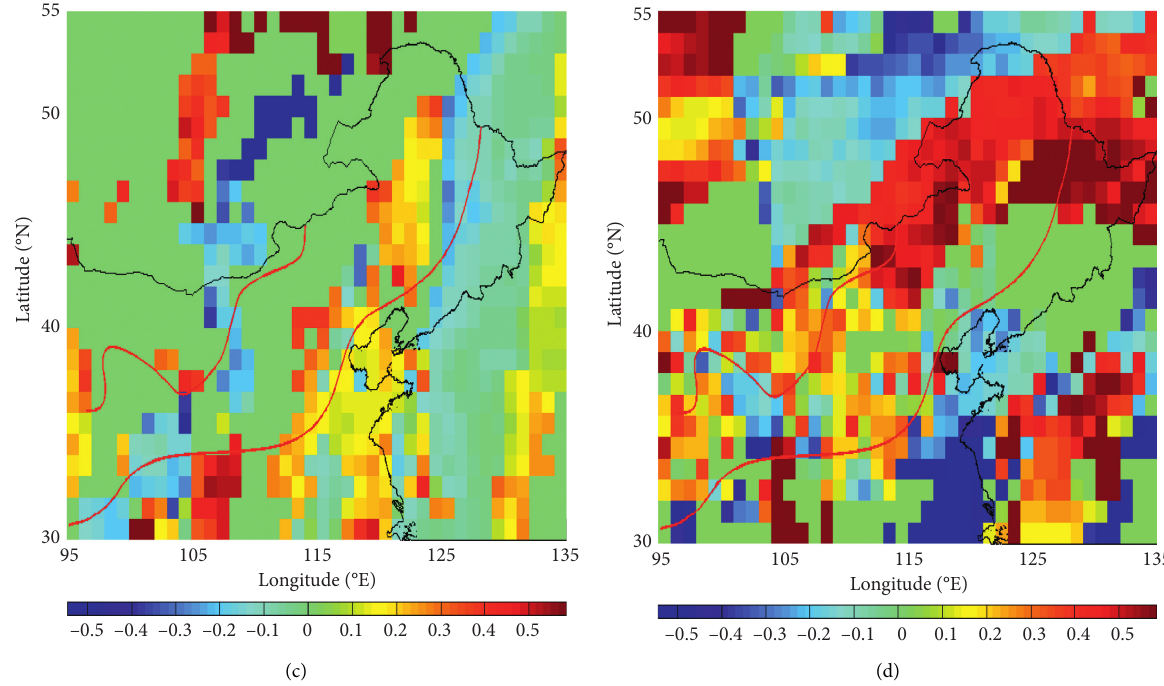
Figure 3: Differences in aerosol optical depth (AOD) between the abundant and deficient EASM years (deficient minus abundant) for (a) June, (b) July, (c) August, and (d)